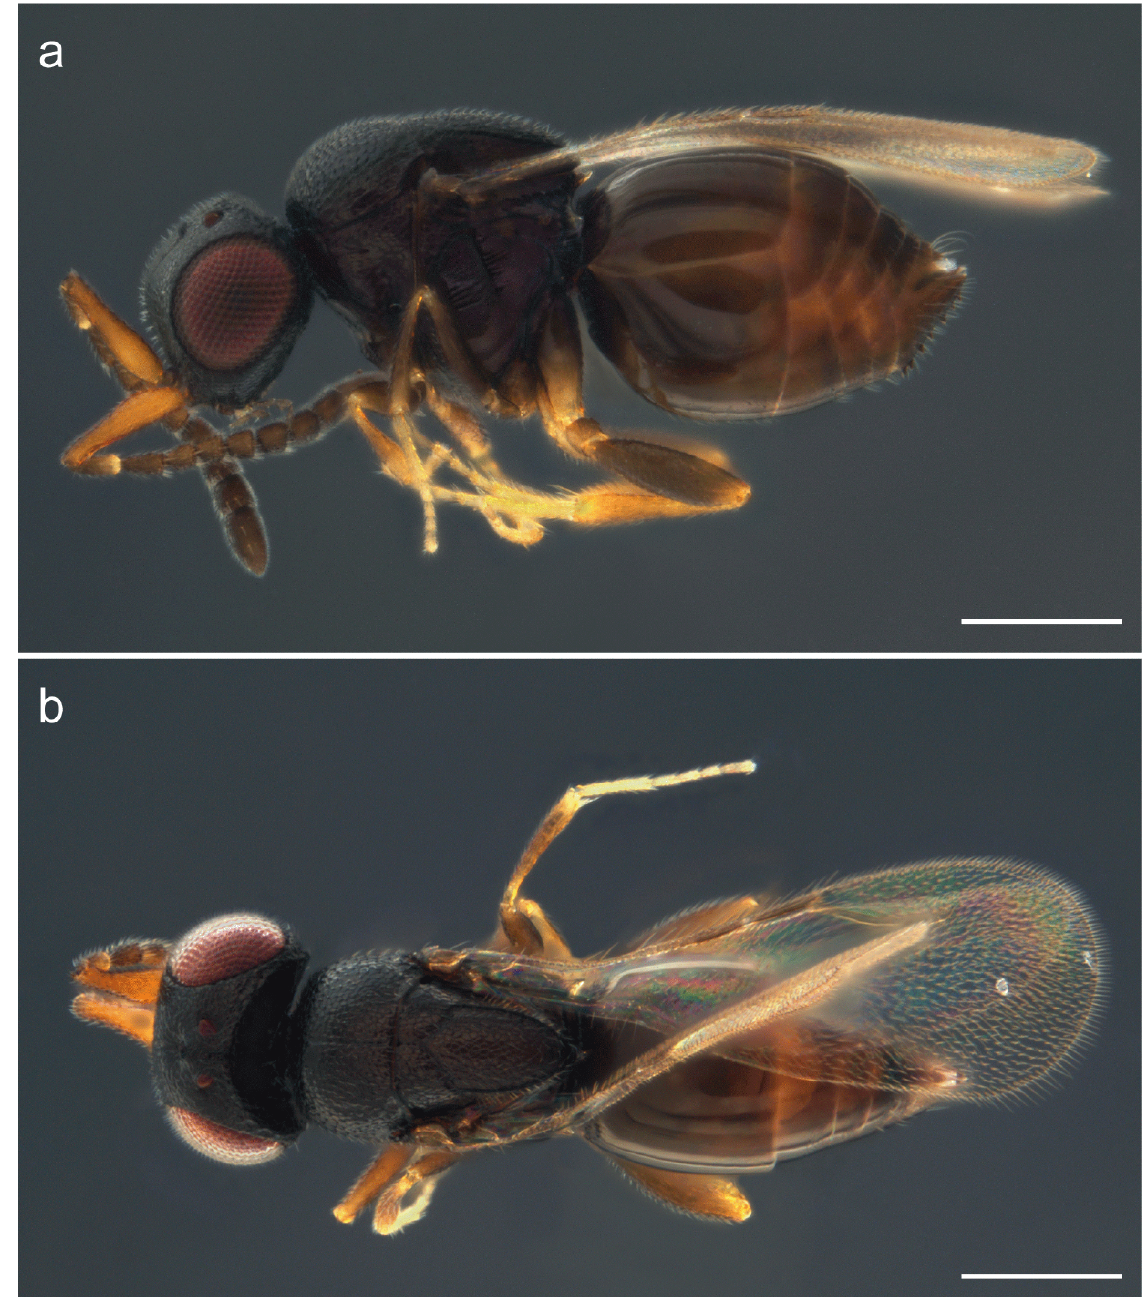
Fig. 1. Aphanogmus kretschmanni Moser sp. nov.; holotype, ♀ (SMNS_Hym_Cer_000227). a . Habitus, lateral view. b . Habitus, dorsal view. Scale bars = 200